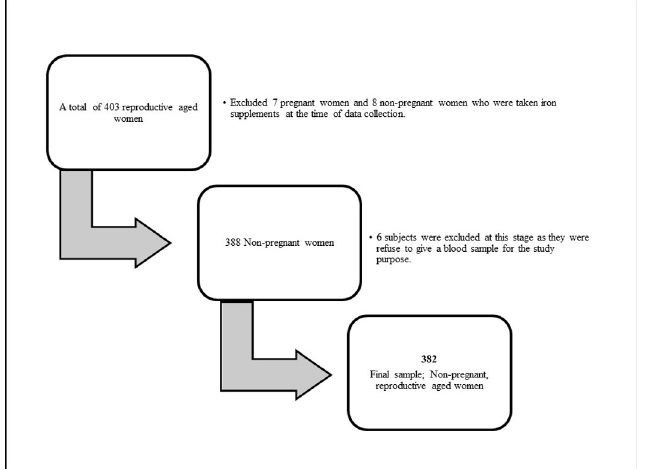
Fig 1. Selection of subjects for the